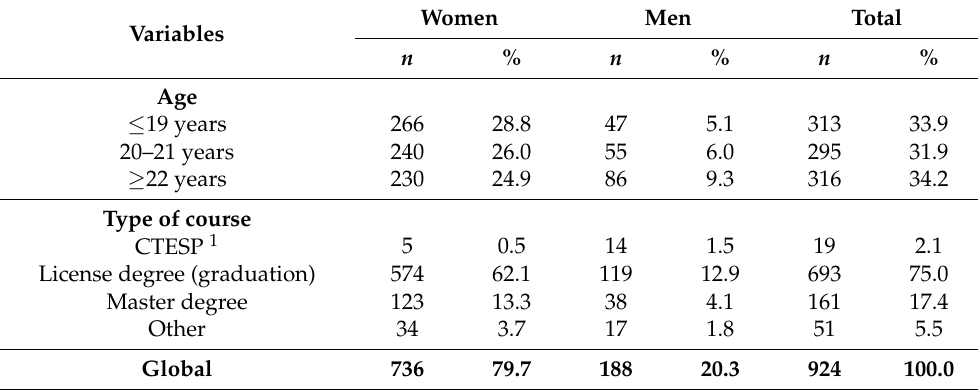
Table 3. Age group and type of course frequented according to sex.